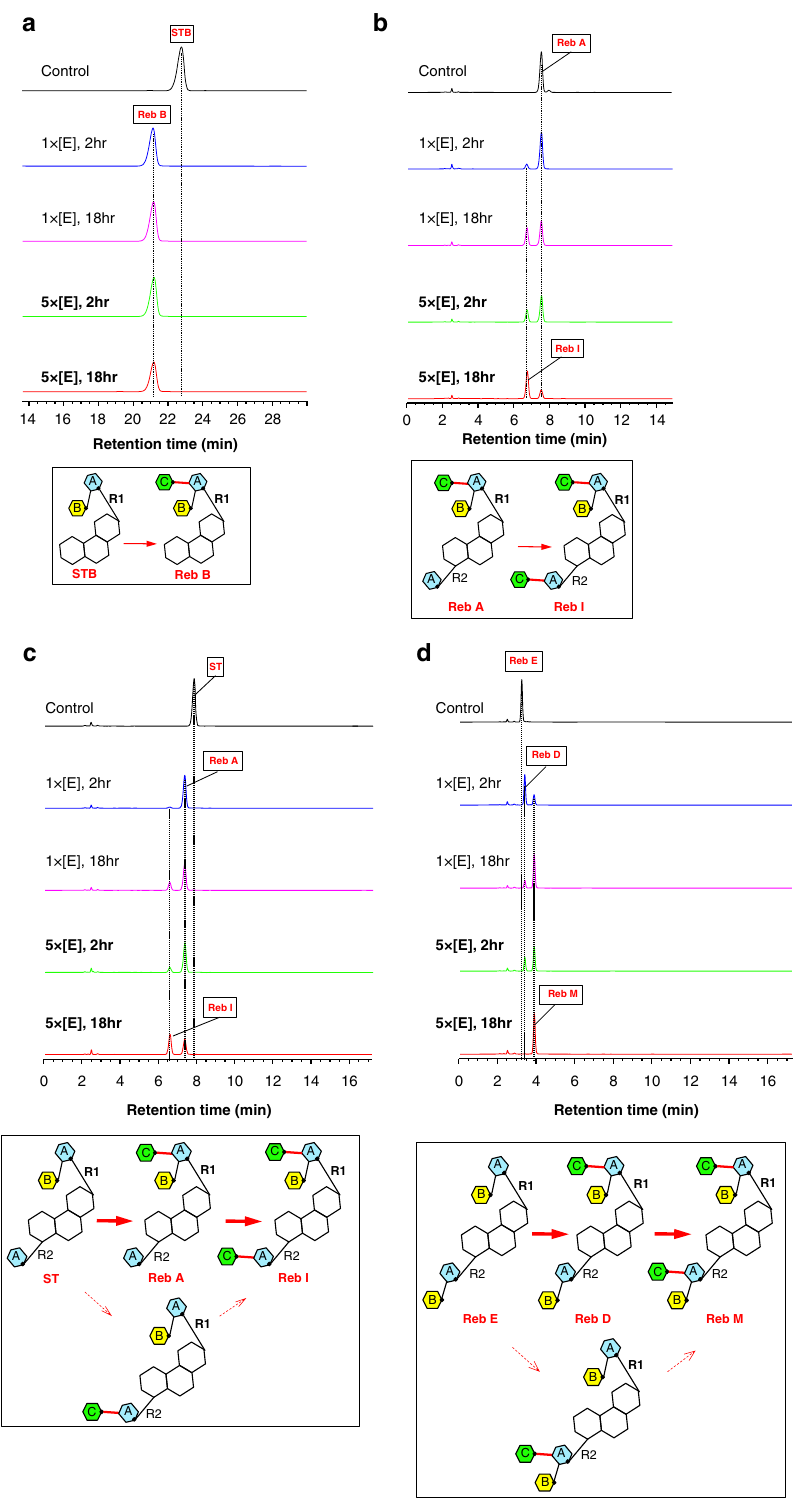
Fig. 2 The steviol products of the sugar transfers by UGT76G1. a – d HPLC traces of the reactions of STB, Reb A, ST, Reb E were analyzed, respectively, by HPLC. The fi ve HPLC traces from top to bottom represent the following reaction conditions: no enzyme for 18 h (black), 0.03 mg ml − 1 enzyme (1×) for 2 h (blue), 0.03 mg ml − 1 enzyme (1×) for 18 h (purple), 0.15 mg ml − 1 enzyme (5×) for 2 h (green) and 0.15 mg ml − 1 enzyme (5×) for 18 h (red). The product is identi fi ed by the authentic standard. The yields of the products are related to the enzyme concentration and the reaction duration. The reactions catalyzed by UGT76G1 are shown in the